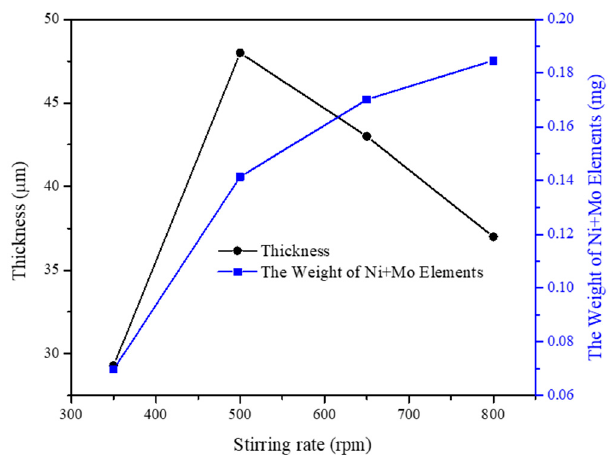
Figure 12. The effect of stirring rate on the weight of deposited Ni + Mo elements in the coatings obtained at the mentioned conditions in the caption of Figure 9.